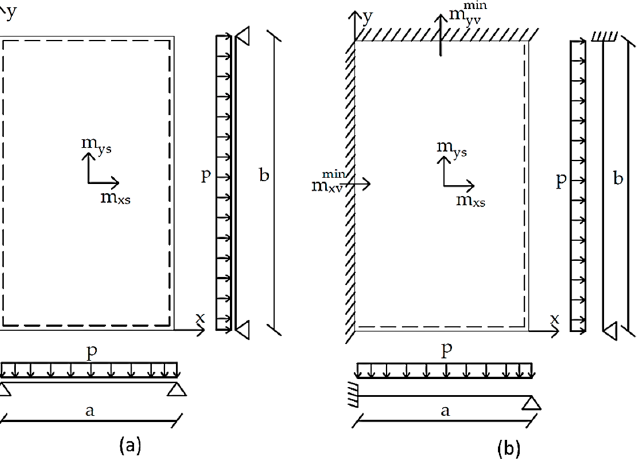
Figure 7. ( a ) The simply supported slab and ( b ) supported fixed-ended slab.